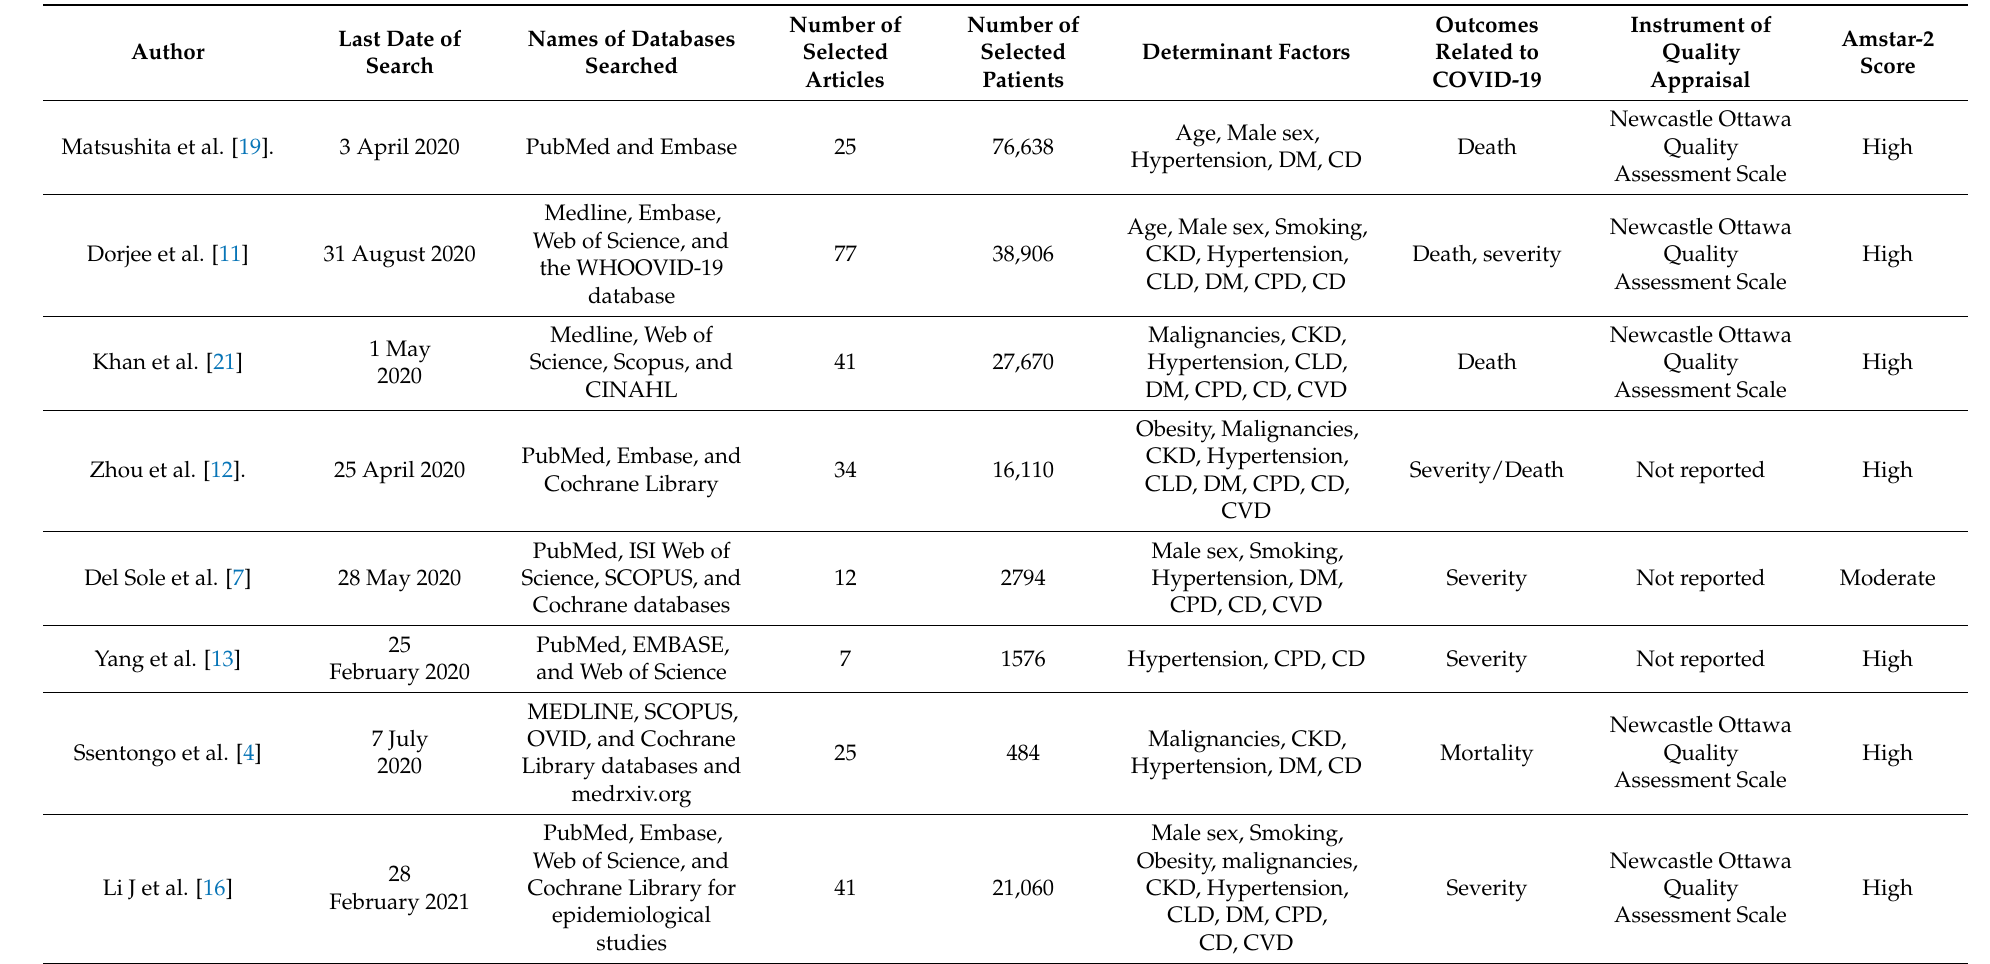
Table 1. Summary of features of the systematic reviews and meta-analyses investigating the outcome impact of patients’ characteristics and underlying conditions included in this